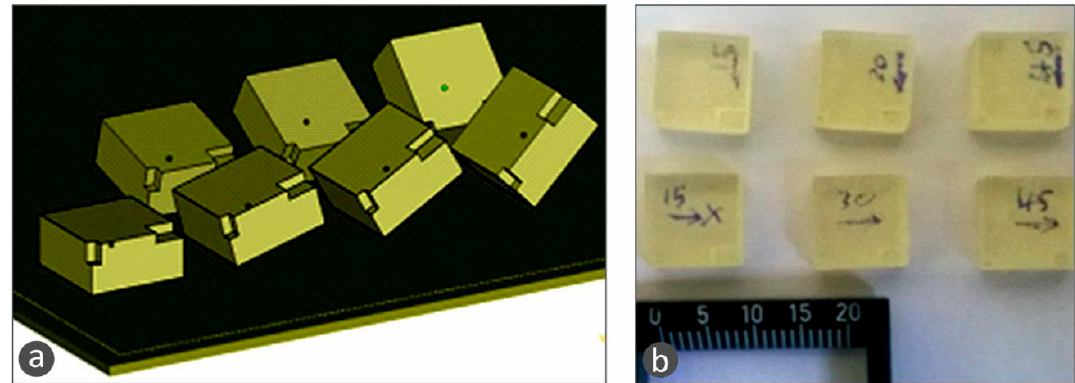
Figure 4. Specimens manufactured by Kechagias and Maropoulos, 2015: ( a ) the orientation the specimens were built in the different cases studied in this work, ( b ) typical samples of the different 3D printed specimens studied in this work.